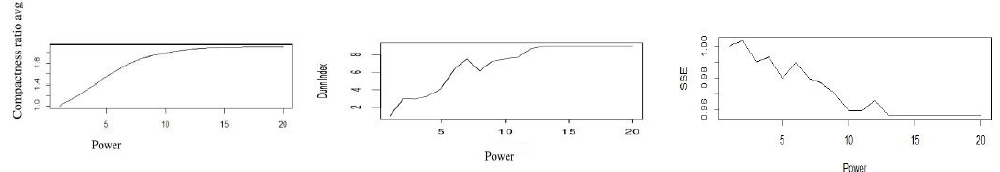
Figure 8. Compactness, Donn index and Sum of Squared errors. Seed dataset. Table 4 contains the exact value of Compactness and the Donn